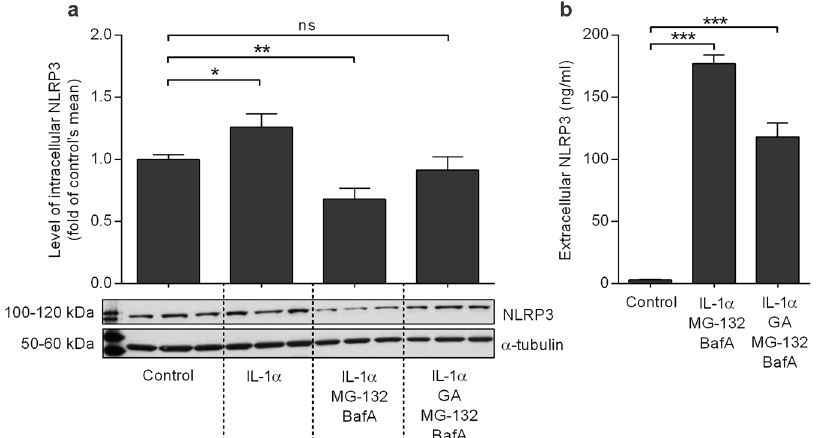
Figure 5. NLRP3 is secreted from the cells when it cannot be degraded by autophagy. The release of NLRP3 is stronger after activation of the NLRP3 inflammasome (concurrent with the release of IL-1 β ) than after inhibition of inflammasome activation by GA ( a , b ). ARPE-19 cells were treated with IL-1 α (24 h), geldanamycin (GA) and MG-132 (24 h), and bafilomycin A1 (BafA; 24 h), and both medium and cell lysate samples were collected. The intracellular NLRP3 concentration was measured from cell lysates using the western blot technique, and a representative blot picture is shown ( a ). The extracellular NLRP3 levels were measured from cell culture medium samples using the ELISA technique ( b ). Bars are presented as mean ± SEM. * P < 0.05, ** P < 0.01, *** P < 0.001, ns = not significant, Mann –Whitney U